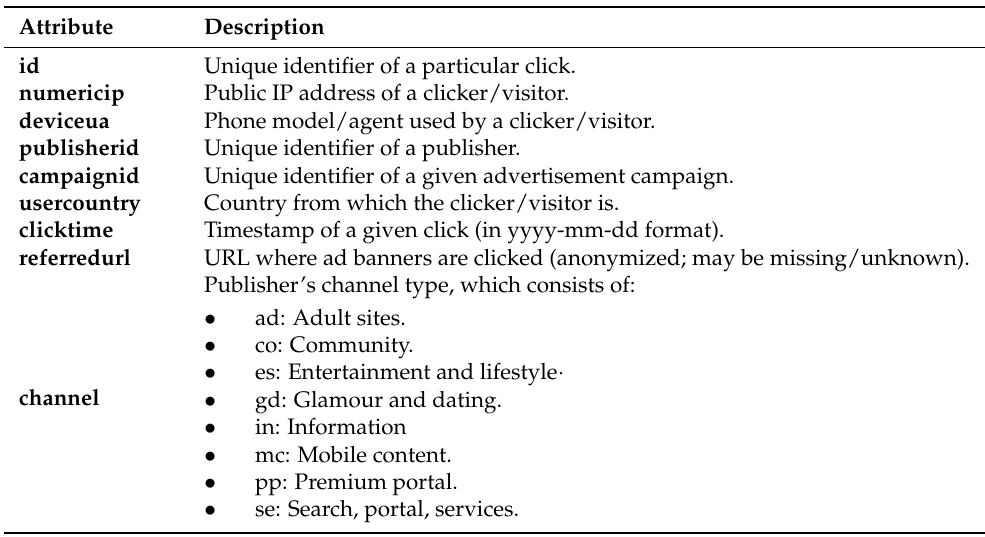
Table 3. Features in the click